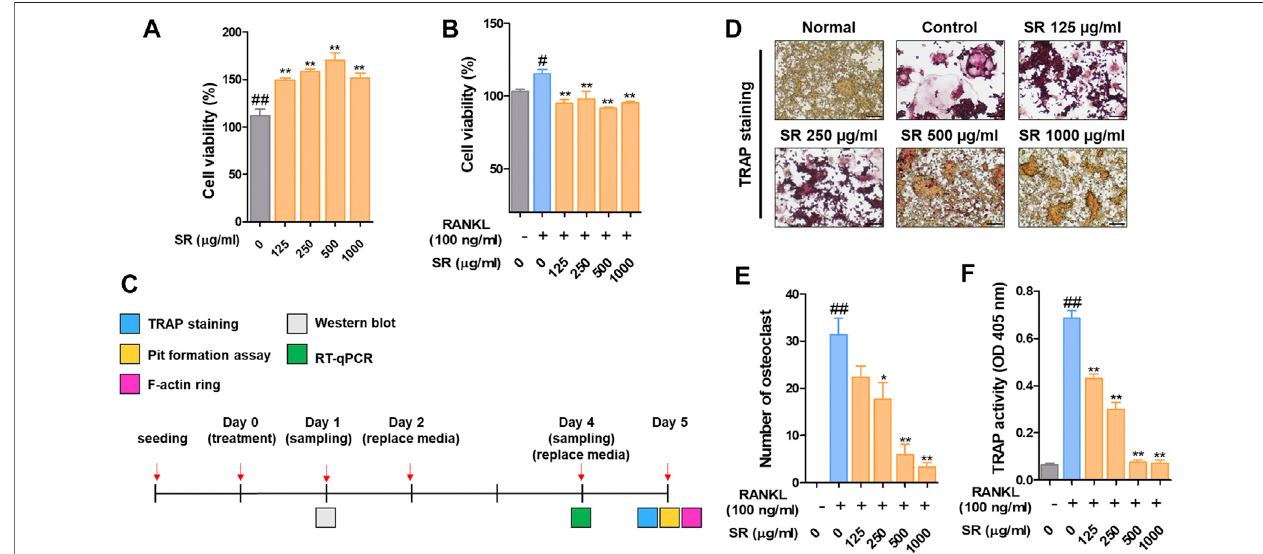
FIGURE 1 | The effects of SR on osteoclast differentiation and bone resorption in RANKL-induced RAW 264.7 cells. (A) RAW 264.7 cell viability was measured using a CCK-8 assay kit. (B) The effects of SR (0, 125, 250, 500, 1,000 μ g/ml) on the viability of osteoclasts induced by RANKL using a CCK-8 assay kit. (C) In vitro experimental design to investigate the effect of SR on osteoclast differentiation. (D) TRAP-positive cells were stained using a TRAP kit. (E) A number of TRAP-positive cells with > 3 nuclei were counted using an inverted microscope (magni fi cation, × 100). (F) TRAP activity was measured using an ELISA reader. Data are presented asthemean ± SDofthreeindependentexperiments.Statisticalanalysiswasperformedusingone-wayANOVAfollowedbyDunnett ’ sposthoctest. # p < 0.05, ## p < 0.01 vs. the normal group (untreated cells); * p < 0.05, ** p < 0.01 vs. the RANKL only treatment